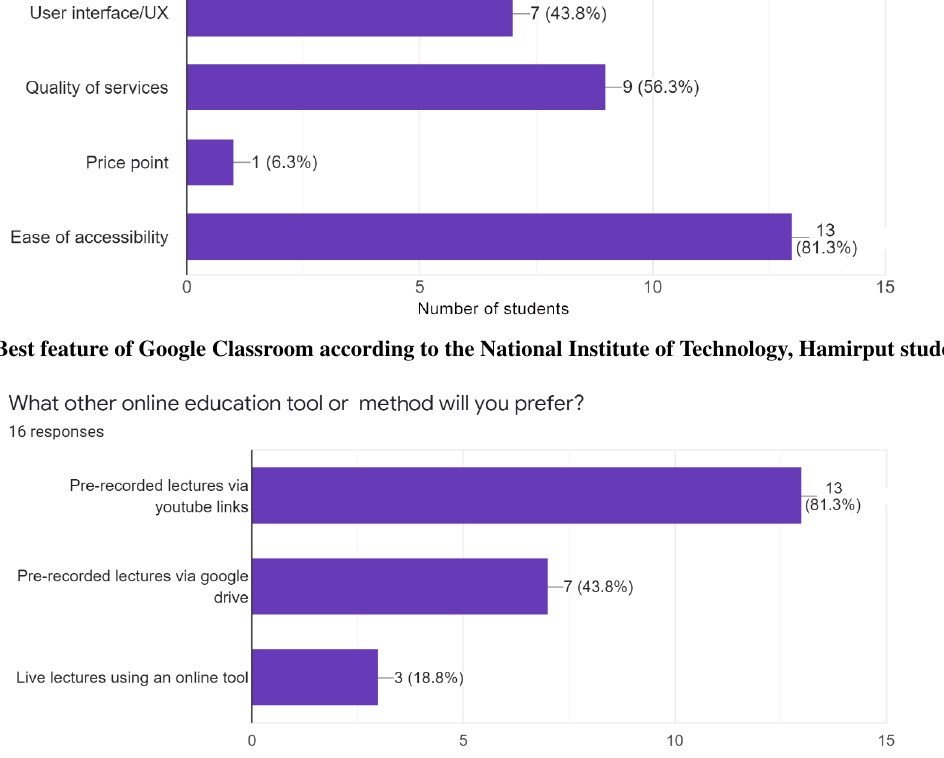
Fig. 5 Online education tool preferred by NIT-H